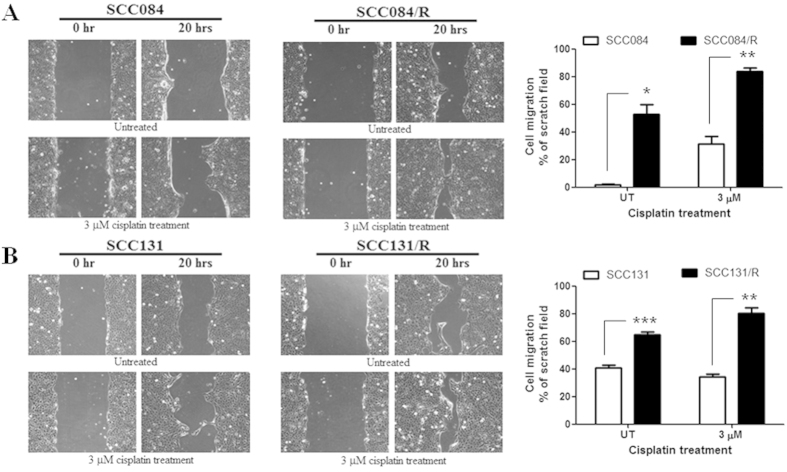
Cellular migration was enhanced remarkably in cisplatin resistant cells.The migration potentiality of resistant and parental OSCC cells was evaluated under microscope (10Χ magnification) by scratch assay in presence or absence of cisplatin. Drug treatment was done for 24 hrs before the scratches made. (A) Upper left panel shows representative images of scratch assay using SCC084 and SCC084/R cells respectively taken at 0 h and 20 h after the scratch made in presence or absence of cisplatin treatment. The upper right panel shows the quantification of cell migration (% of scratched areas) after 20 hrs calculated using Image J in SCC084 and SCC084/R cells. (B) Lower left shows representative images of scratch assay using SCC131 and SCC131/R cells respectively taken at 0 h and 20 h after the scratch made in presence or absence of cisplatin treatment. The lower right panel shows the quantification of cell migration (% of scratched areas) after 20 hrs calculated using Image J in SCC131 and SCC131/R cells. Images are representative of three independent experiments. In the bar-diagram the data expressed as mean ± SE. *p < 0.05, **p < 0.01, ***p < 0.001.